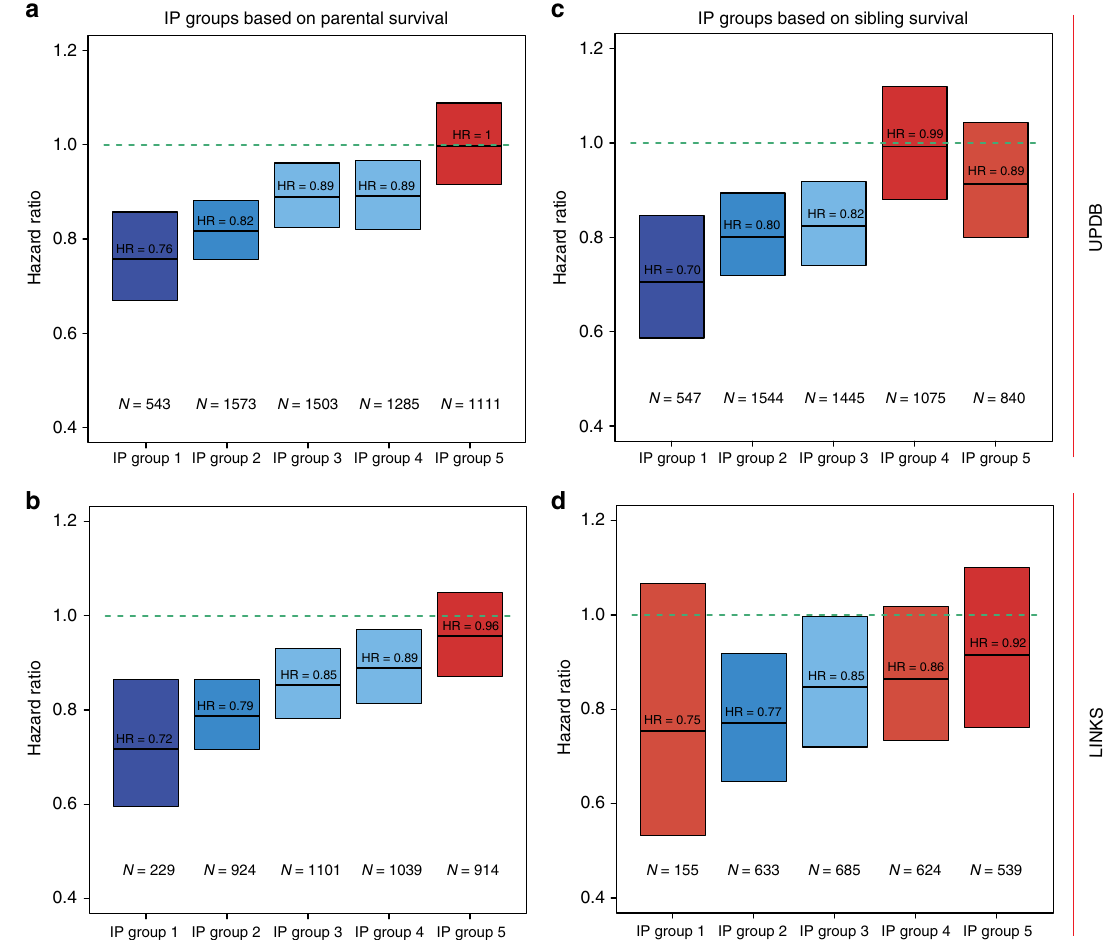
Fig. 3 Hazard ratio for IPs grouped by their relatives ’ survival in mutually exclusive groups. Parent and sibling groups: group 1 = IPs of whom the longest lived parent/sibling belonged to the [ ≥ 0th & ≤ 1th percentile] of their birth cohort, group 2 = IPs of whom the longest lived parent/sibling belonged to the [ ≥ 1th & ≤ 5th percentile], group 3 = IPs of whom the longest lived parent/sibling belonged to the [ ≥ 5th & ≤ 10th percentile], group 4 = IPs of whom the longest lived parent/sibling belonged to the [ ≥ 10th & ≤ 15th percentile], group 5 = IPs of whom the longest lived parent/sibling belonged to the [ ≥ 15th & ≤ 20th percentile], group 6 = IPs of whom the longest lived parent/sibling belonged to the [ ≥ 20th & ≤ 100th percentile]. The left column (panels a and b ) shows the HRs of IP groups 1 – 5 compared to group 6 and depicts a parental grouping. The right column (panels c and d ) shows the HRs of IP groups 1 – 5 compared to group 6 and depicts a sibling grouping. Groups were colored by the extremity of the HR. The darker the blue the stronger the survival bene fi t, the darker the red, the weaker the survival bene fi t and the effect was not signi fi cant with the red colors. The green lines represent the reference category, which is group 6. N green line at the top-right = 4759, N green line at the top-left = 4227, N green line at the bottom-right = 7477, N green line at the bottom-left = 5907. All estimates are adjusted for religion (UPDB only), sibship size, birth cohort, sex, socio-economic status, mother ’ s age at birth, birth order, birth intervals, twin birth, and number of top 10% parents or number of top 10% siblings for the sibling and parent analyses, respectively. Error bars represent con fi dence